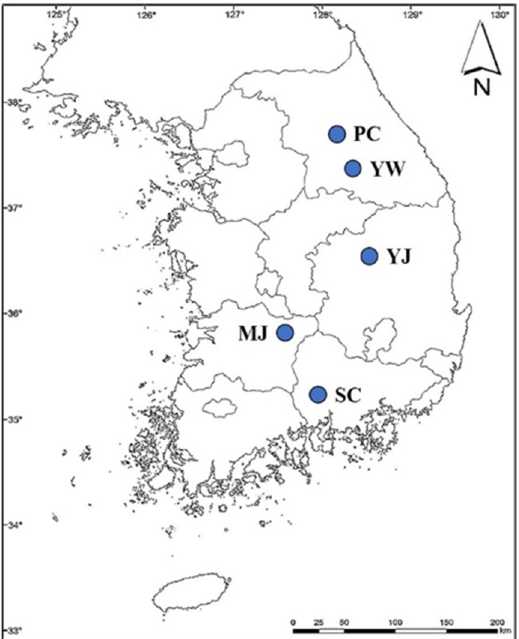
Figure 1. Sampling locations of wild-simulated ginseng. PC: Pyeongchang, YW: Yeongwol, YJ: Yeongju, MJ: Muju, SC: Sancheong.